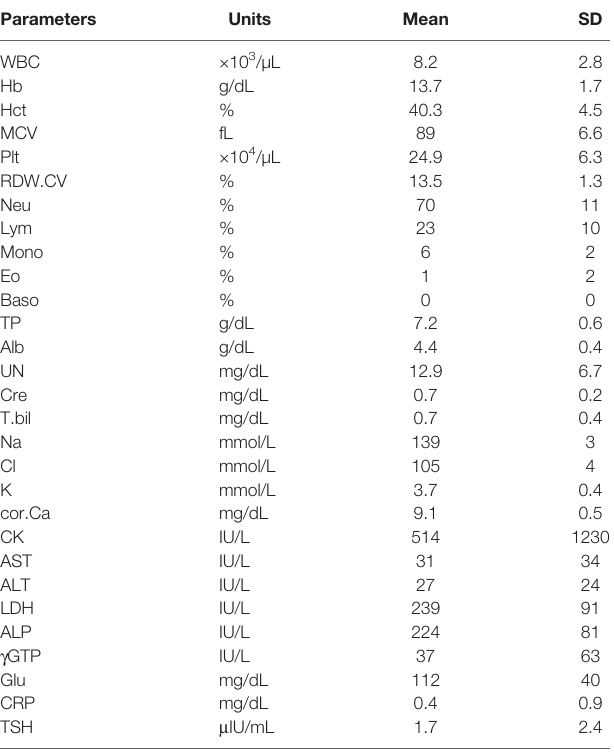
TABLE 3 | Summary of full dataset of 29 parameters for machine-learning.